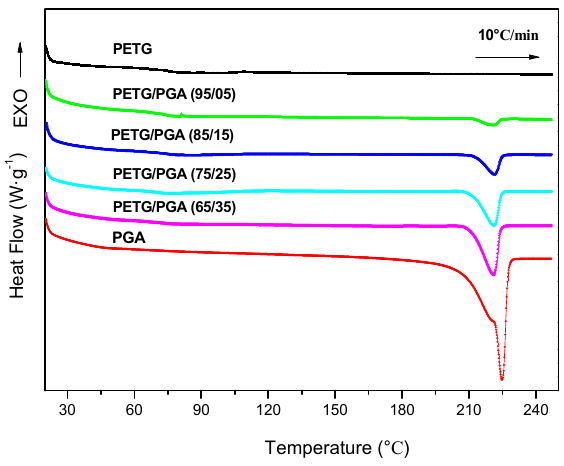
Figure 4. Heating DSC thermographs of PETG/PGA (y/z) samples. Table 3. Differential scanning calorimetry (DSC) parameters of neat PGA, PETG, and PETG/PGA (y/z) samples. Samples